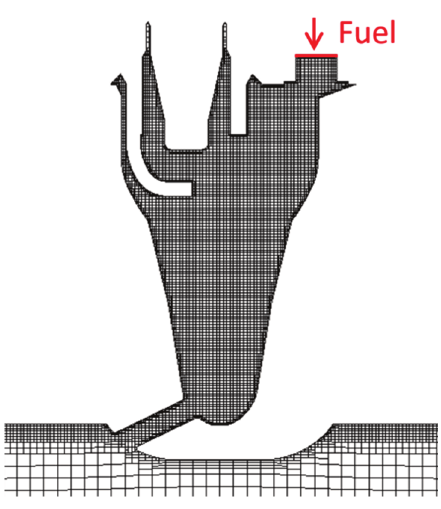
Fig. 3. RANS grid of 0.18 mm in the spark-plug symmetry plane